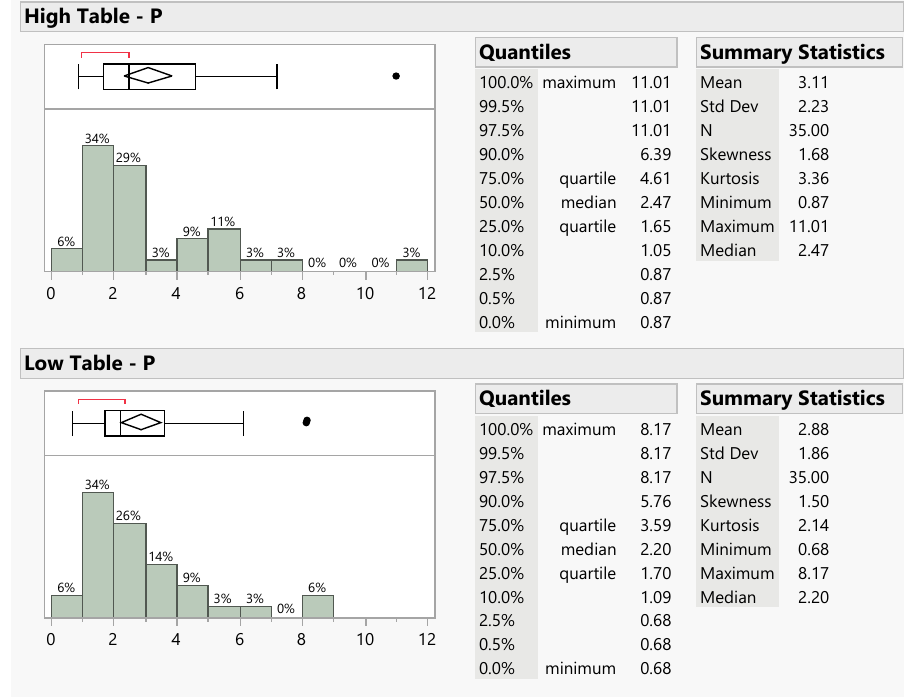
Figure 9. Distributions and statistics of P data collected from the high table ( top panel) and low table ( bottom panel). Each panel includes a box-and-whisker plot ( top left corner) a histogram ( bottom left corner) and descriptive statistics ( right side) for paired samples collected using a high or low table in the top and bottom panels, respectively. The distributions are skewed but have similar means and medians. Three outliers were removed. Data units are mg/m 2 .